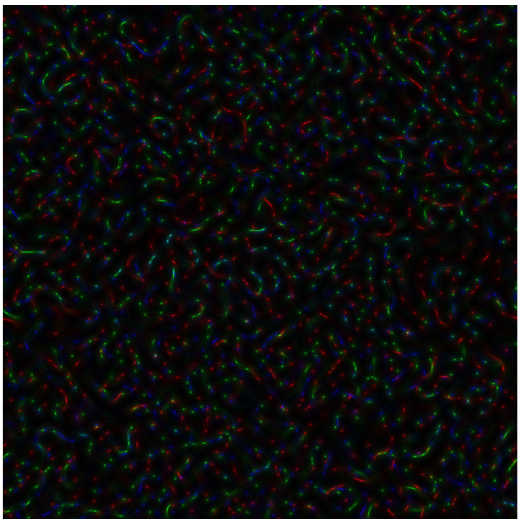
Figure 3c. Coloured s-LASCA images of GB-speckles, generated for more three SARS – CoV-2 genes (the gene#5, the gene#6 and the